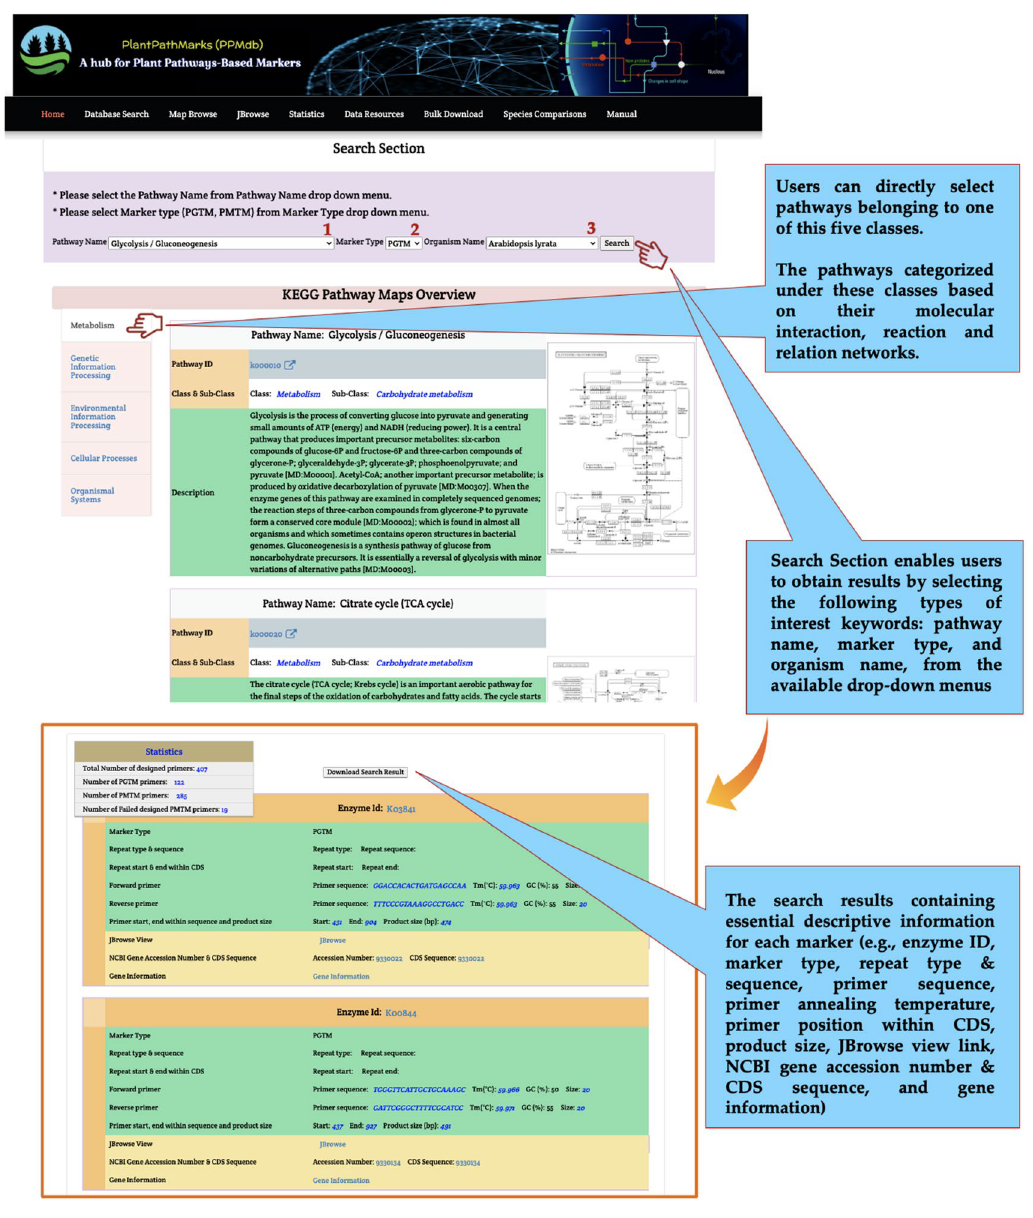
Figure 3. Screenshot of the PPMdb “Database Search” page